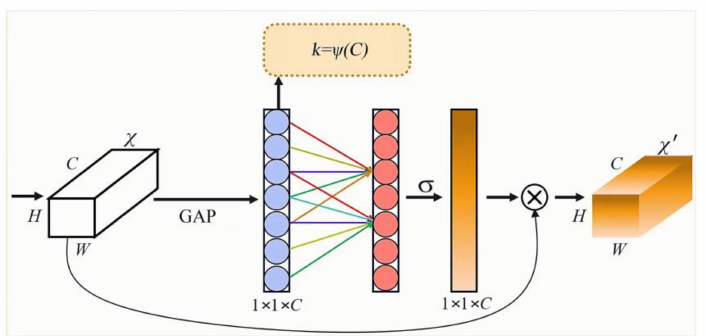
Figure 3. ECA module.